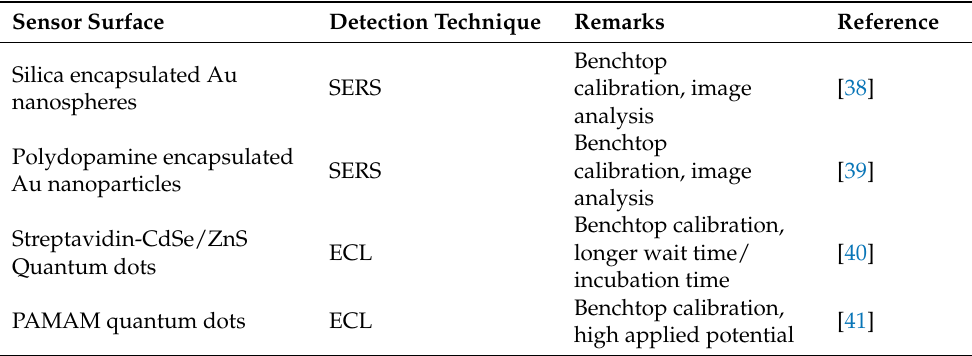
Table 3. Comparison of developed portable nanosensor, highlighting its current status with respect to few reported multiplexed